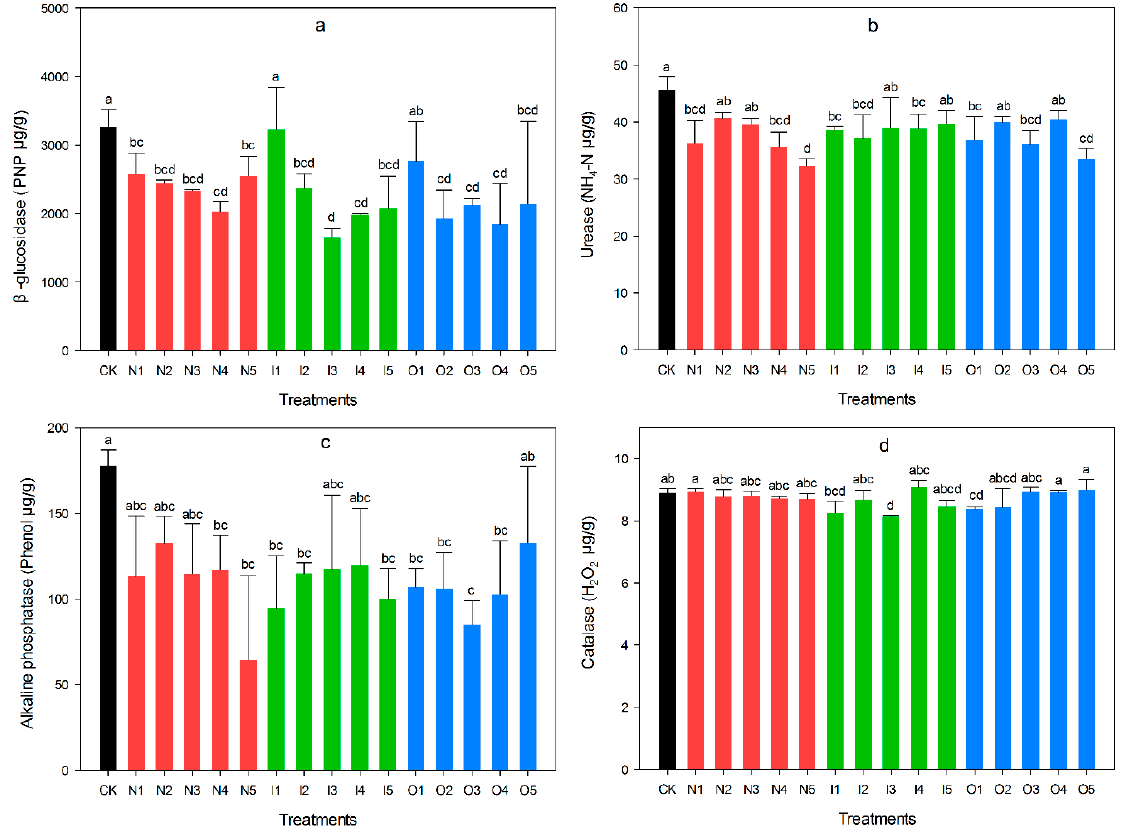
Figure 4. Changes of four enzyme activities in different set ‐ aside patterns in spring, ( a ) β ‐ glucosidase ( b ) urease ( c ) alkaline phosphatase ( d ) catalase. The black bar represented control (CK), red bar represented no management (N1–N5), the green bar represented only irrigation (I1–I5), the blue bar represented organic management (O1–O5).